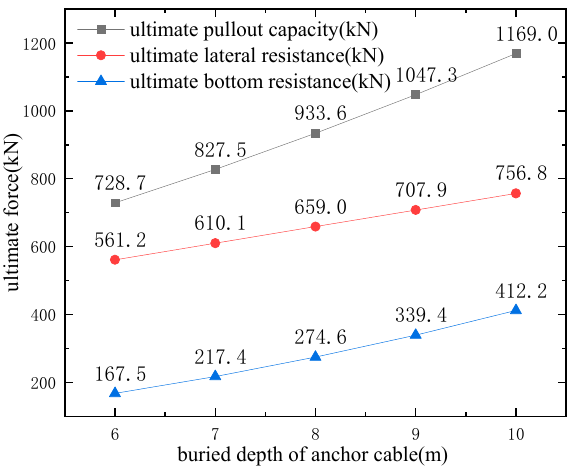
Figure 19. The ultimate force variation curves according to the change in the buried depth of anchor cable.